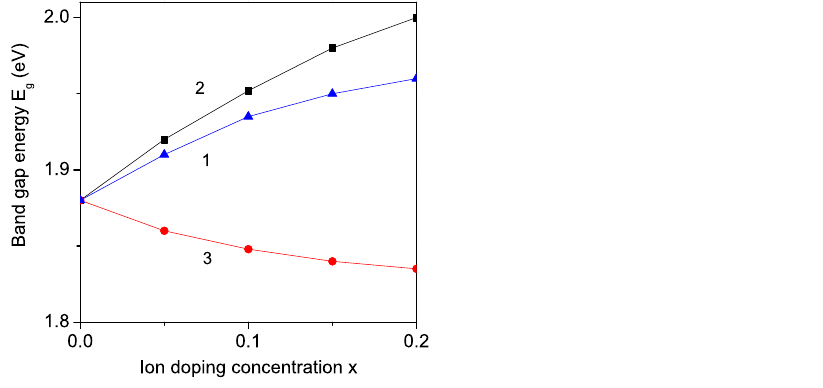
Figure 8. (Color online) Ion doping concentration dependence of the band gap energy Eg of a YFO nanoparticle (N = 10 shells) by (1) Ti doping with J d = 0.8 J b ; (2) Sm doping with J d = 0.6 J b ; (3) Co doping with J d = 1.4 J b